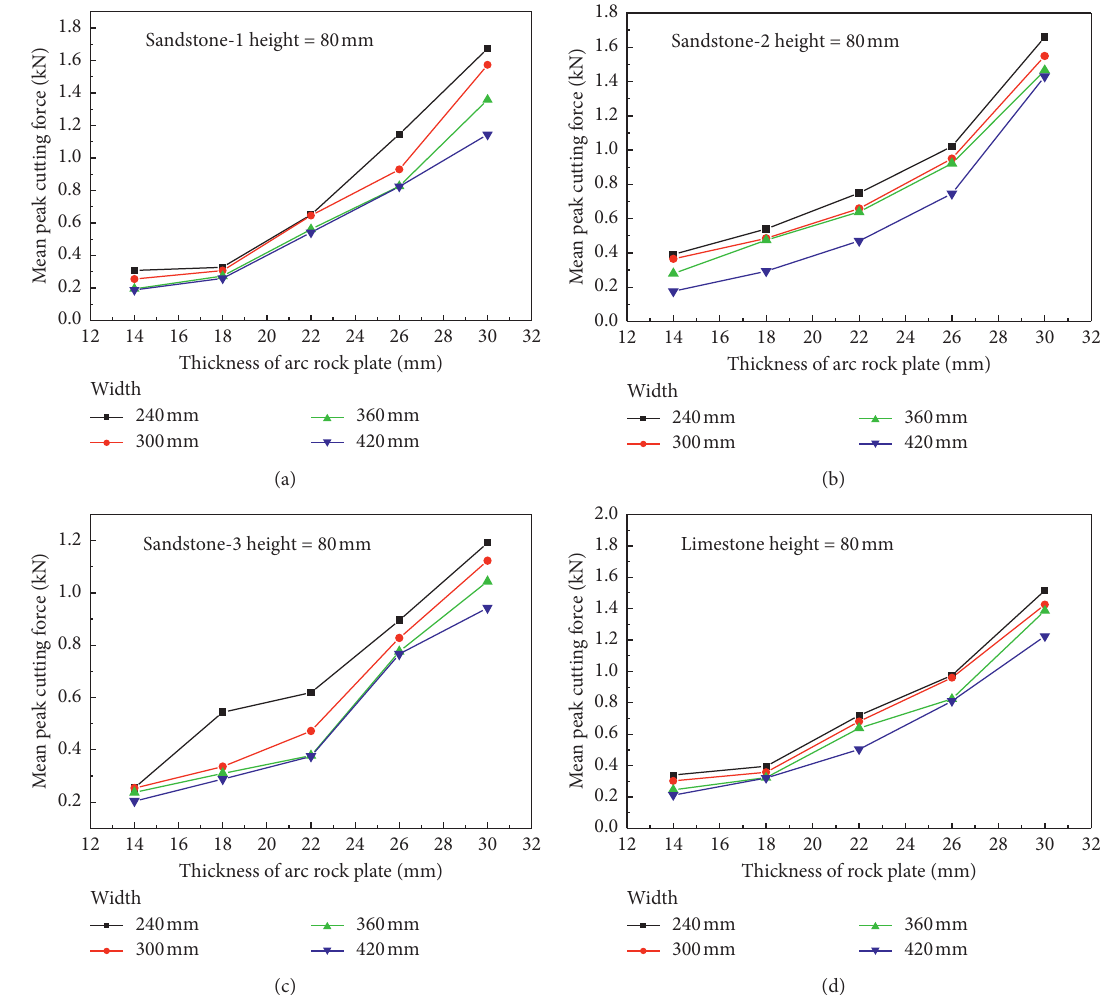
Figure 15: The mean peak cutting force curve with various thickness of arc rock plate.